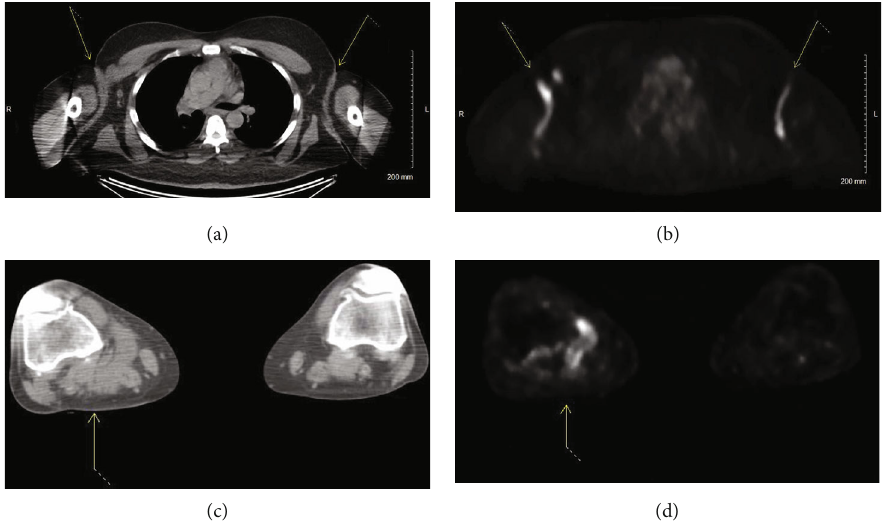
Figure 2: PET/CT imaging prior to starting radiotherapy. Axial CT of patient axilla (arrows) (a) and corresponding PET image (b). Axial CT of patient ’ s right popliteal mass (arrow) (c) and corresponding PET image (d).